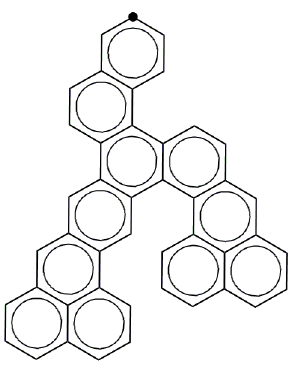
Figure 5. An asymmetric atom possessing weighted atomic sum of zero.